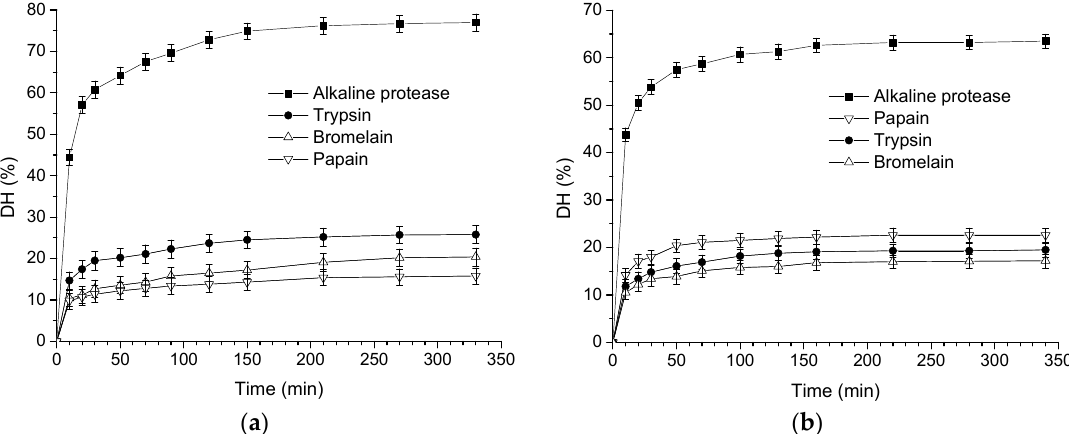
Figure 1. Effect of four proteases on the degree of hydrolysis (DH) from skimmed milk: ( a ) goat milk and ( b ) cow milk. Hydrolysis conditions were as follows. Alkaline protease 5%, 45 °C, pH 9.5; trypsin 5%, 37 °C, pH 8.0; bromelain 5%, 45 °C, pH 6.0; papain 5%, 37 °C, pH 7.0. The error bars represent standard deviation of means ( n = 3).